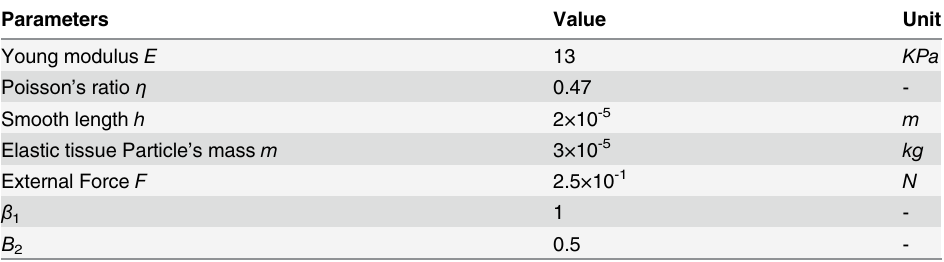
Table 3. Essential Parameters of the Versatile Particle Framework.